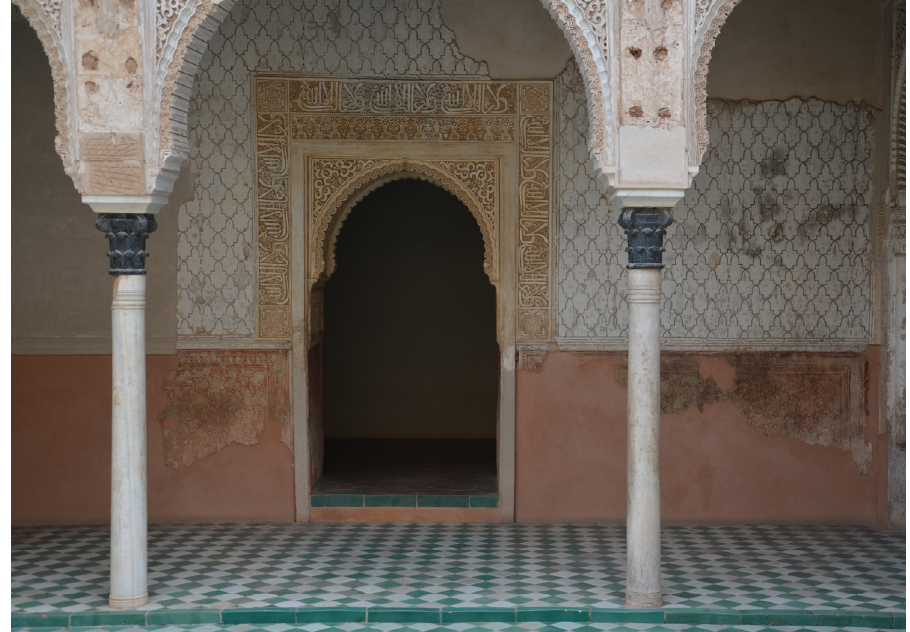
Figure 1. Photograph of the East portico in the Harem Court.